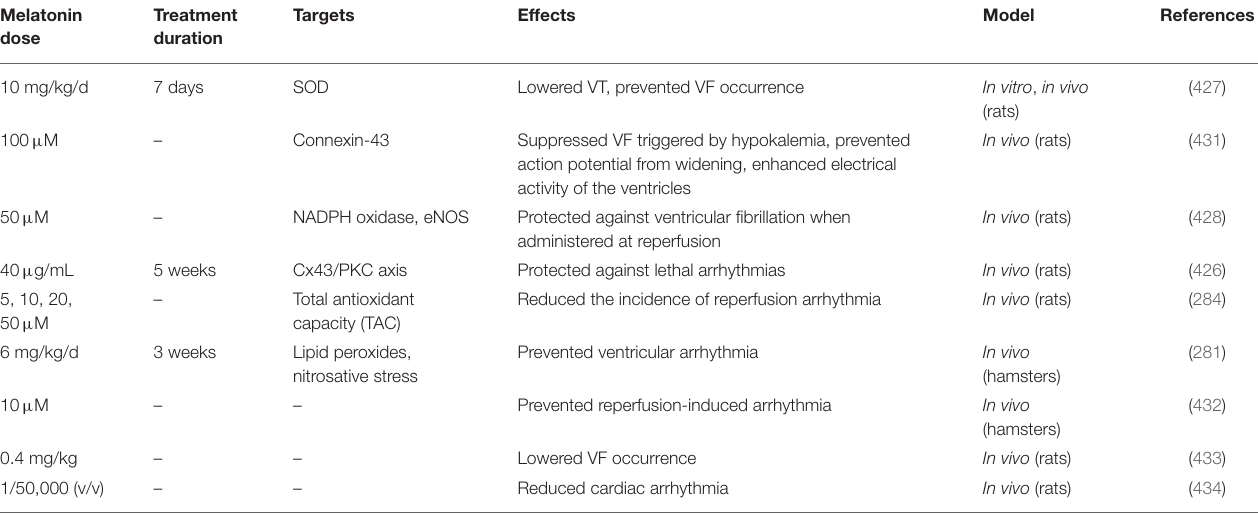
TABLE 6 | Melatonin and cardiac arrhythmia.